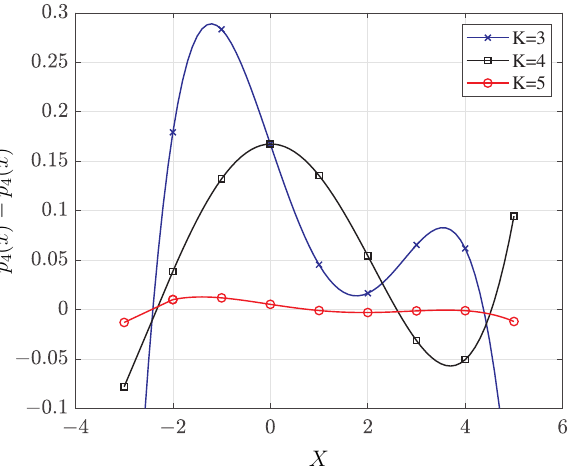
Figure 4. The estimation error, p 4 ( x )